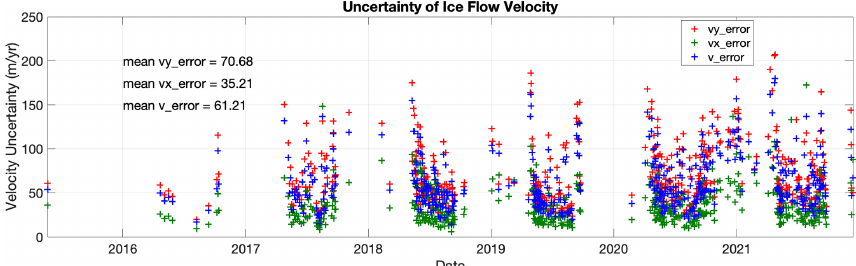
Figure 14. Uncertainty in ITS_LIVE Sentinel-1 image-pair velocities shown in Fig. 13 as provided in the product. Uncertainties of vx, vy and v are calculated according to Eq. (3).